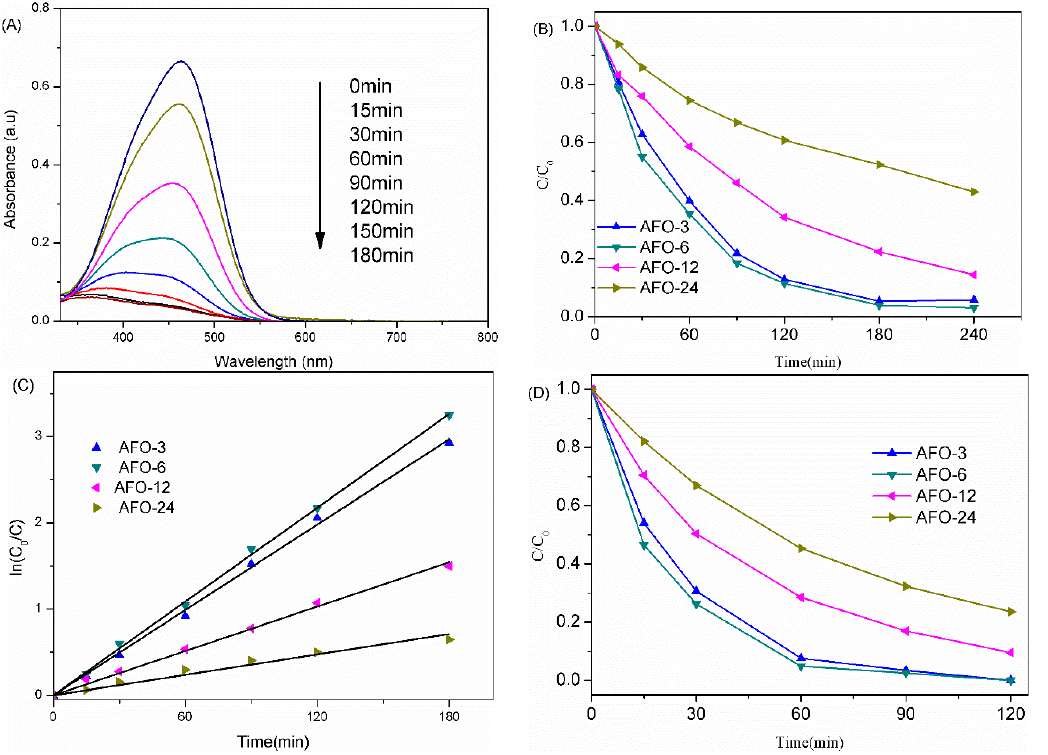
Figure 7. Time ‐ dependent UV ‐ vis absorption spectra of MO in the presence of AFO ‐ 6 ( A ) Figure 7. Time-dependent UV-vis absorption spectra of MO in the presence of AFO-6 ( A ) Time-course Time ‐ course variation of C / C 0 of MO solution ( B ). Linear simulation curves of MO variation of C / C 0 of MO solution ( B ). Linear simulation curves of MO photodegradation ( C ) and photodegradation ( C ) and time ‐ course variation of C / C 0 of BPA solution ( D ) under visible light time-course variation of C / C 0 of BPA solution ( D ) under visible light illumination over AgFeO 2 illumination over AgFeO 2 samples with different reaction times. samples with different reaction